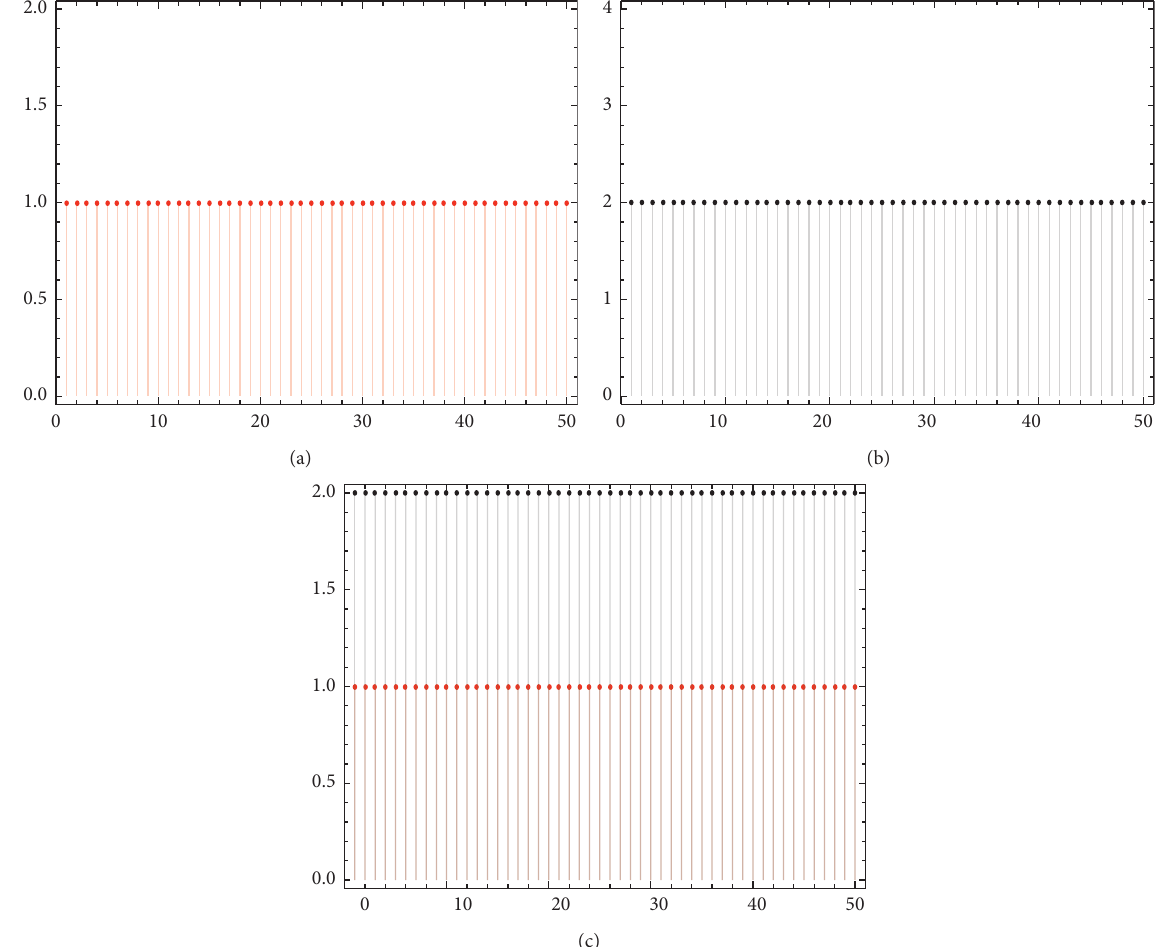
Figure 6: Graph of sequences of rotationally symmetric hexagonal planar networks H i